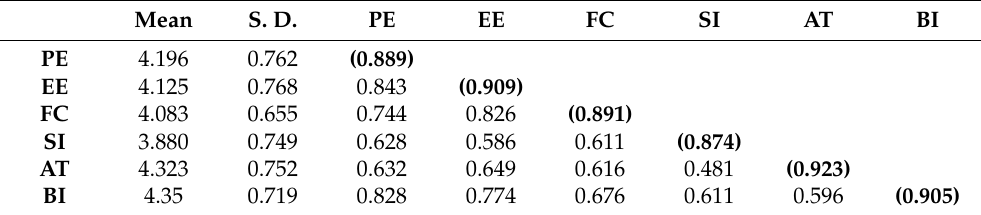
Table 2. Discriminant